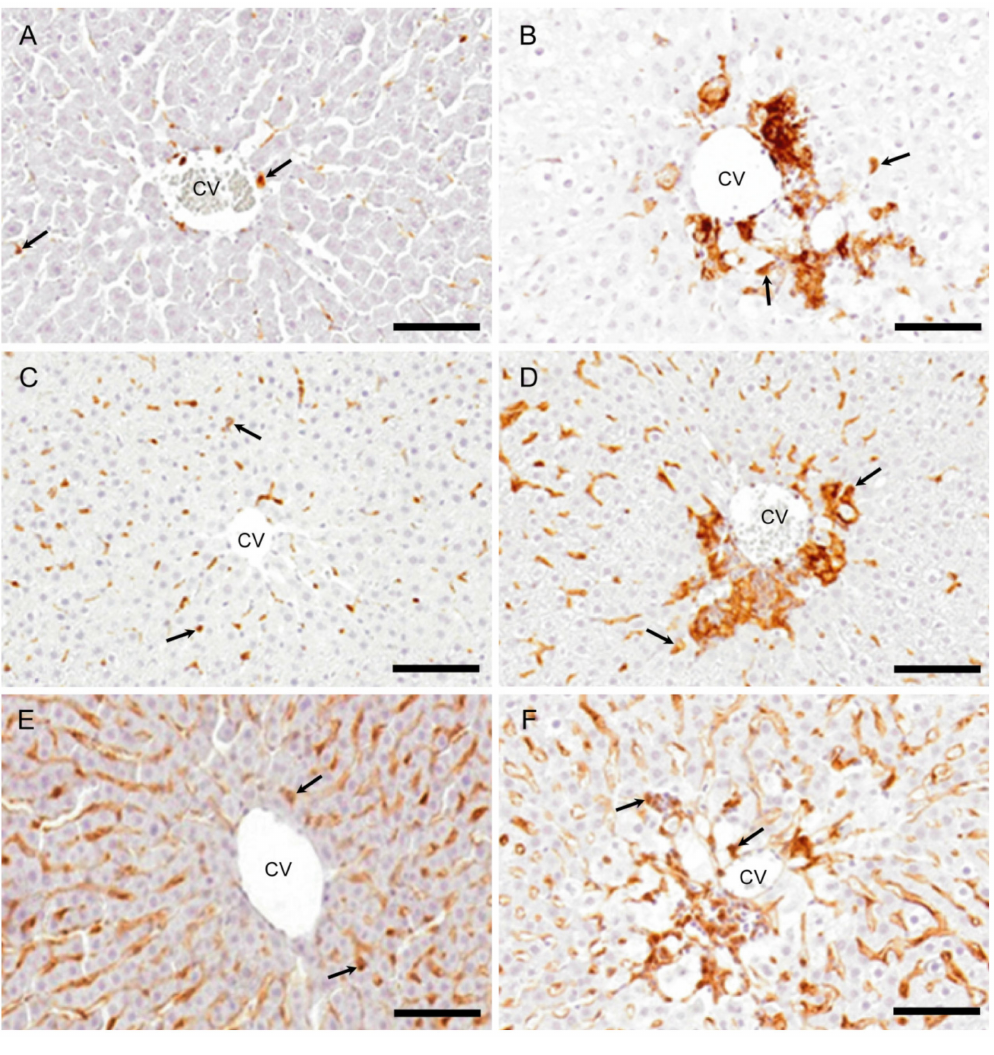
Figure 5. Immunohistochemistry for MHC class II, Iba1, and CD204. Some macrophages are expressing MHC class II ( A ), Iba1 ( C ), and CD204 ( E ) in the centrilobular areas of the control livers. On day 2, the increased numbers of macrophages expressing MHC class II ( B ), Iba1 ( D ), and CD204 ( F ) are seen in the a ff ected centrilobular area. Arrows indicate immunopositive cells. Immunohistochemical staining, counterstained with hematoxylin. CV, central vein. Bar = 50 µ m.